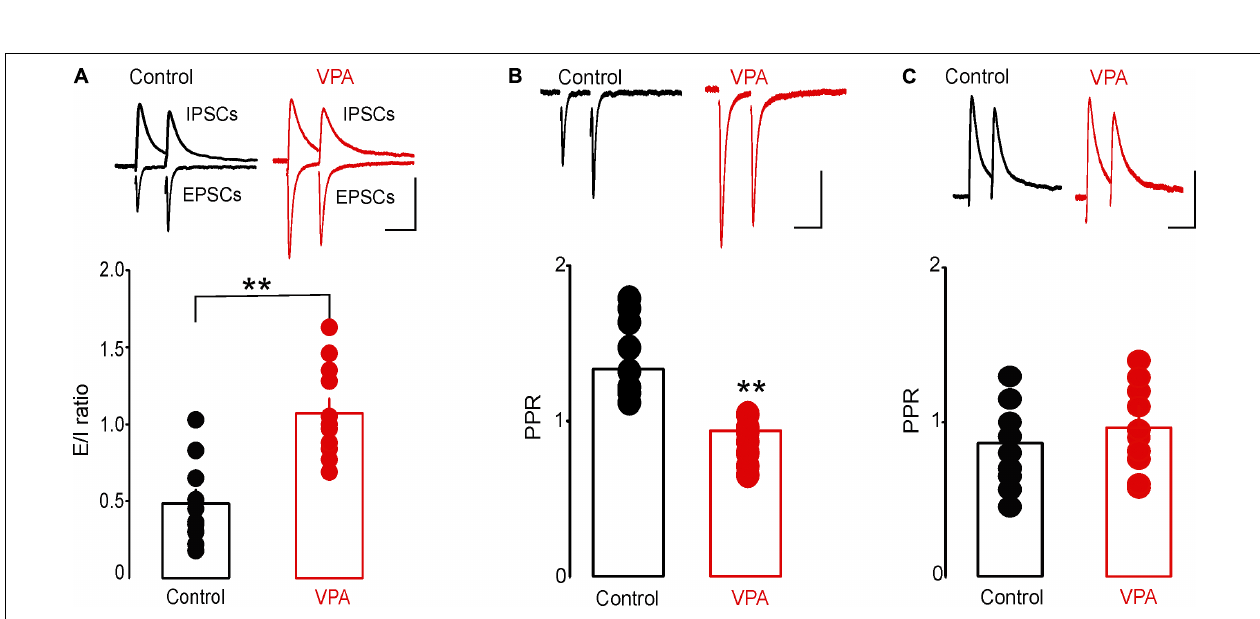
FIGURE 2 | Prenatal VPA exposure has no effect on the intrinsic excitability of dorsal raphe nucleus (DRn) 5-HT neurons. (A) Prenatal VPA exposure does not alter input resistance of DRn 5-HT neurons. (B) Prenatal VPA exposure does not alter the evoked firing activity of DRn 5-HT neurons. Upper panel illustrates the responses (number of action potentials) of DRn 5-HT neurons to depolarizing current pulses obtained in slices from control (left traces) and VPA exposed rats (right traces). Lower panel depicts the average input-output curves of responses obtained in control ( • , n = 8 cells) and VPA rats ( • , n = 8 cells). Data are presented as Mean ± SEM. Scale bars for the upper traces: 25 mV (vertical), 200 ms (horizontal).